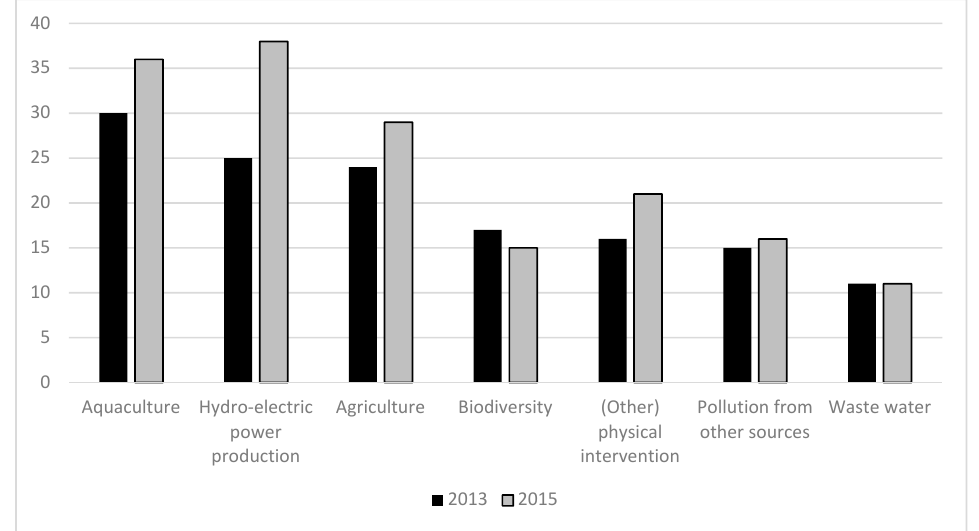
Figure 2. Percentage of river basin district (RBD) board members indicating that it is very di ffi cult or di ffi cult to reach agreement on issues related to the seven policy sectors (marked value 4 or 5 on a five-point Likert scale). (N = 301; 231) [47] (p.